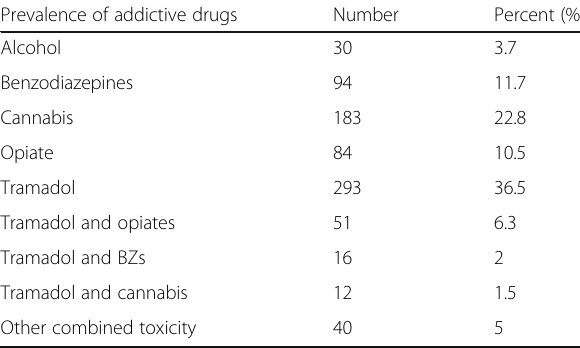
Table 2 Toxicological results of addictive drugs involved in